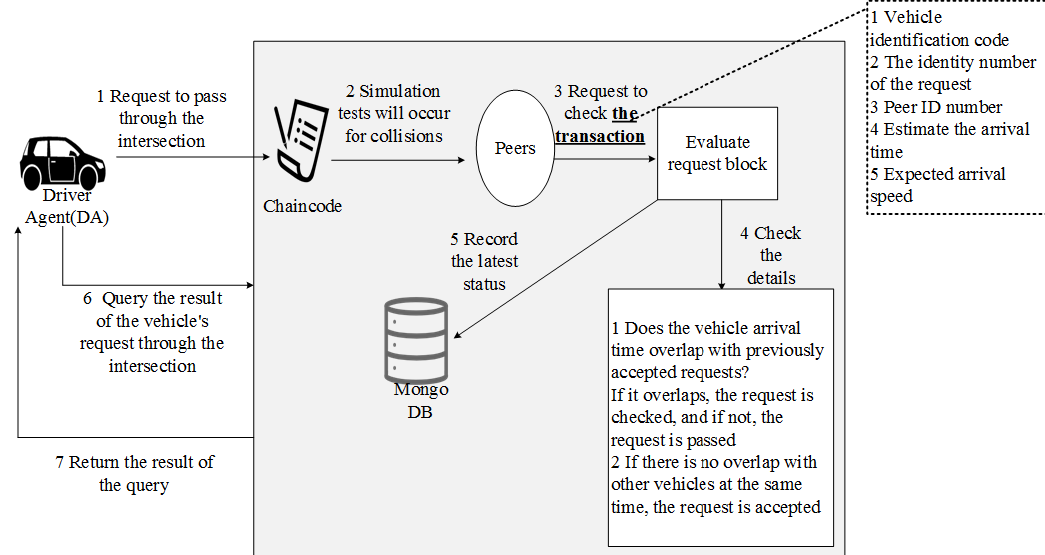
Electronics 2022 , 11 , x FOR PEER REVIEW Figure 36. Reconstruction diagram of reference [68]. Figure 36. Reconstruction diagram of reference [68].